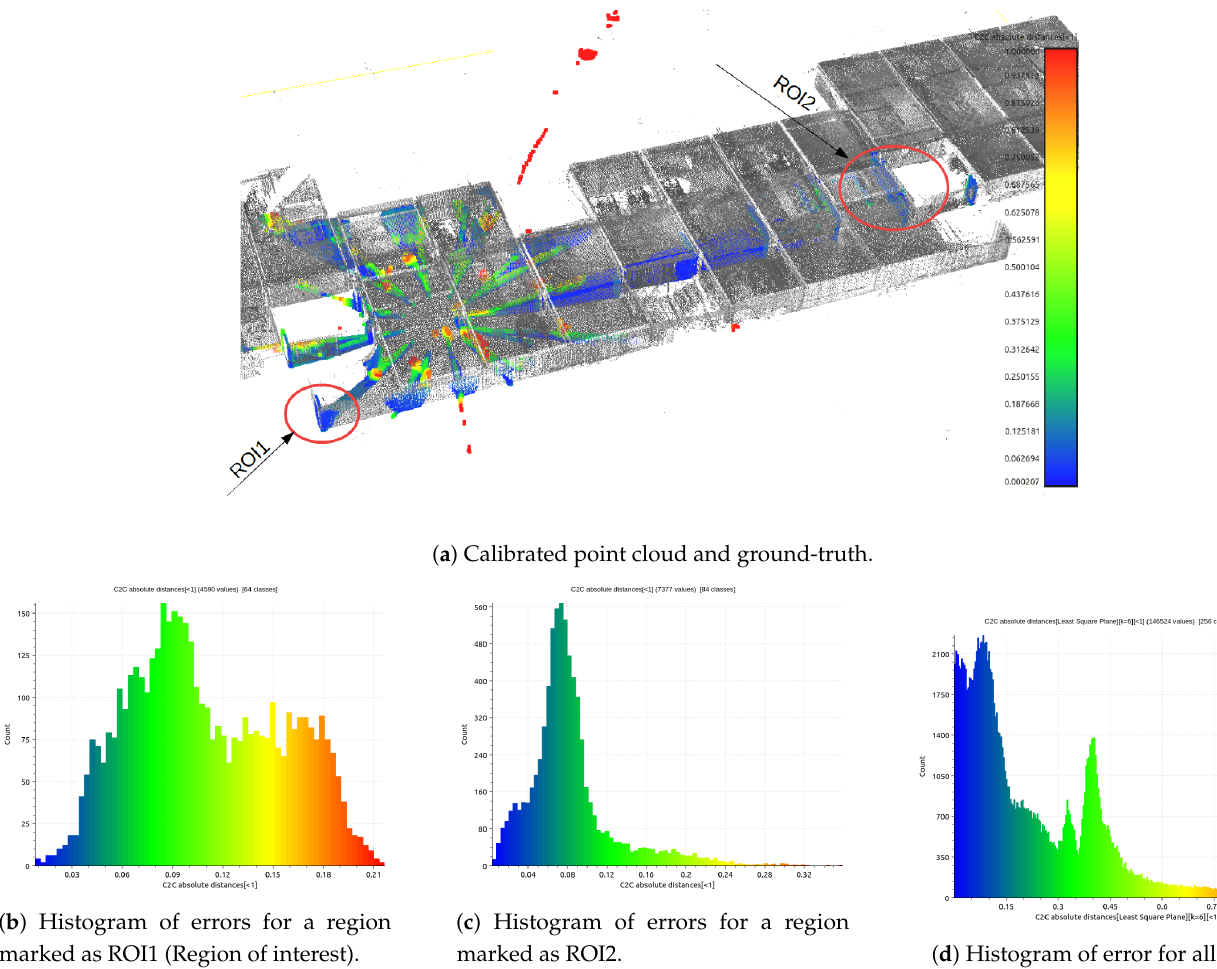
Figure 9. Result of calibration algorithm for single measurement station without ground-truth data (simplest scenario).